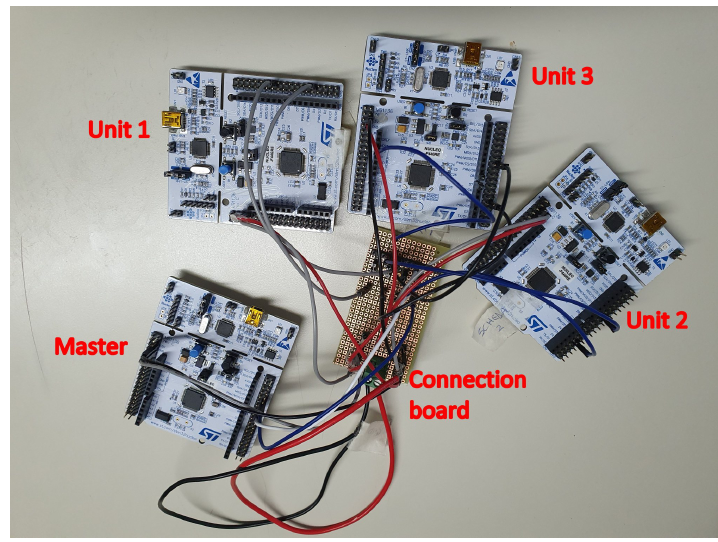
Figure 2. Photo of the test